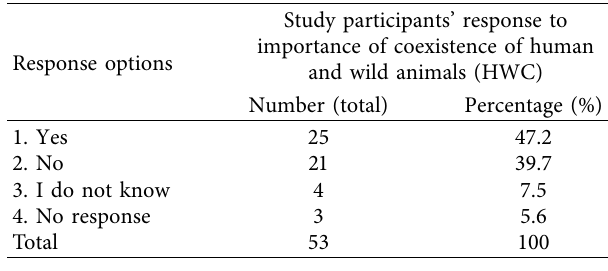
Table 14: Response to importance of coexistence of human and wild animals.